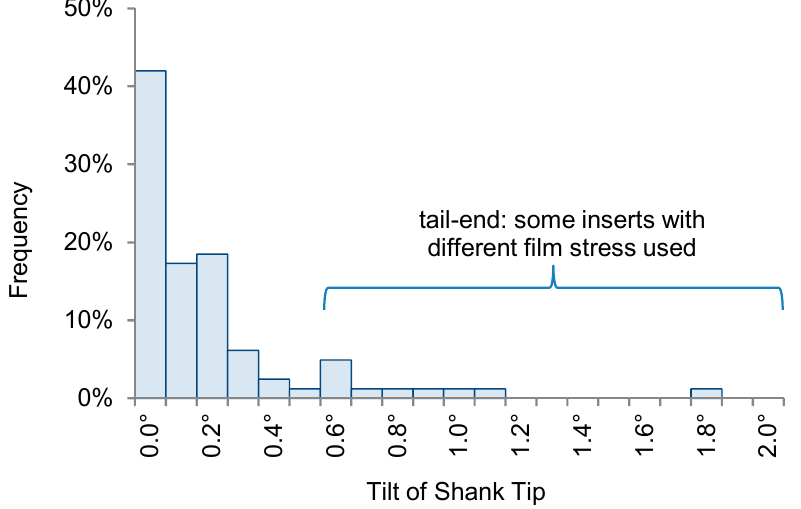
Figure 11. Measurements of the alignment accuracy based on six assembled 3-D probes. The strongly tilted shank tips were due to probe parts from wafers with different film stresses, resulting in an increased misalignment due to shank bending. For inserts with identical film stress, the shank tips are pointing within ±0.2° of their mean, equivalent to the tip of a 5 mm long shank being within 20 µm of the intended position.